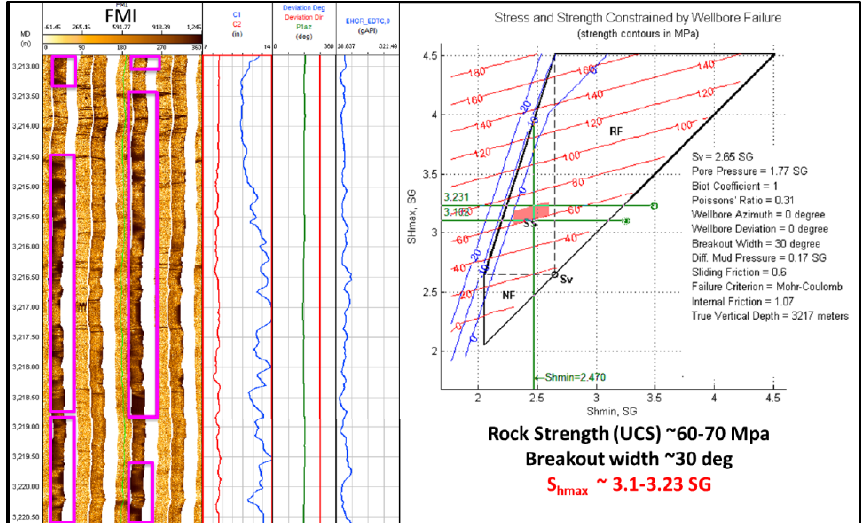
Figure 18. S Hmax magnitude determination of W205 at 3217 m TVD.